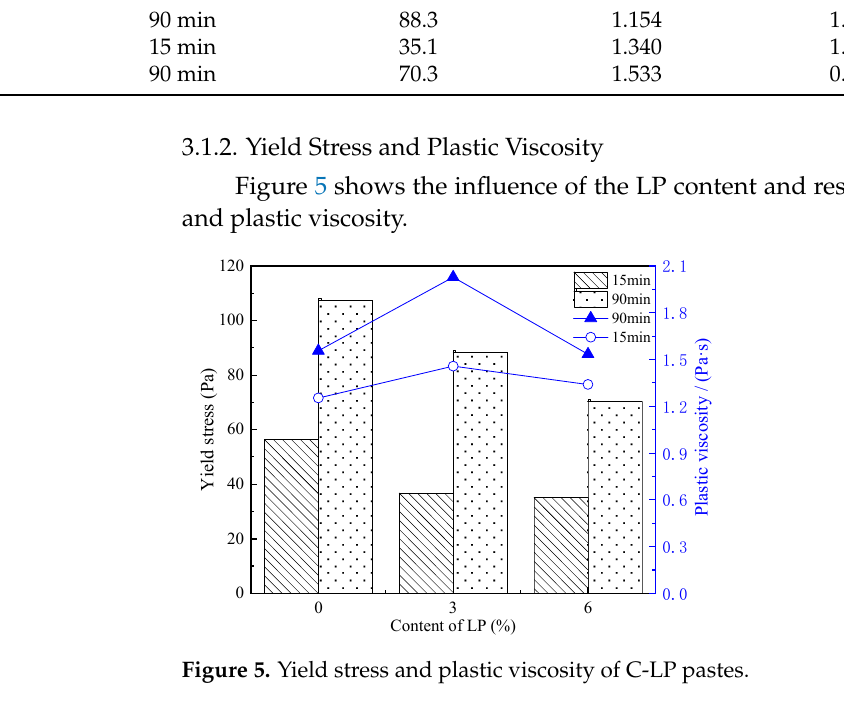
Figure 6. Thixotropic area of C-LP pastes.